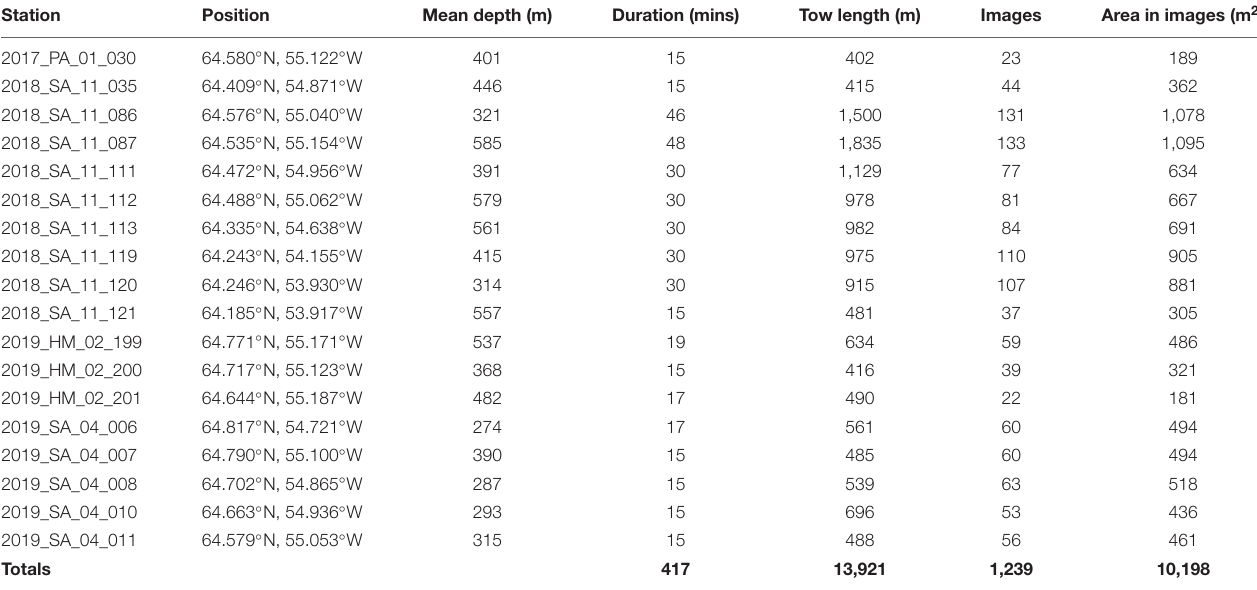
TABLE 3 | List of stations where the benthic video sled was deployed on the continental slope of the Toqqusaq Bank, west Greenland. Station Position Mean depth (m) Duration (mins) Tow length (m) Images Area in images (m 2 )